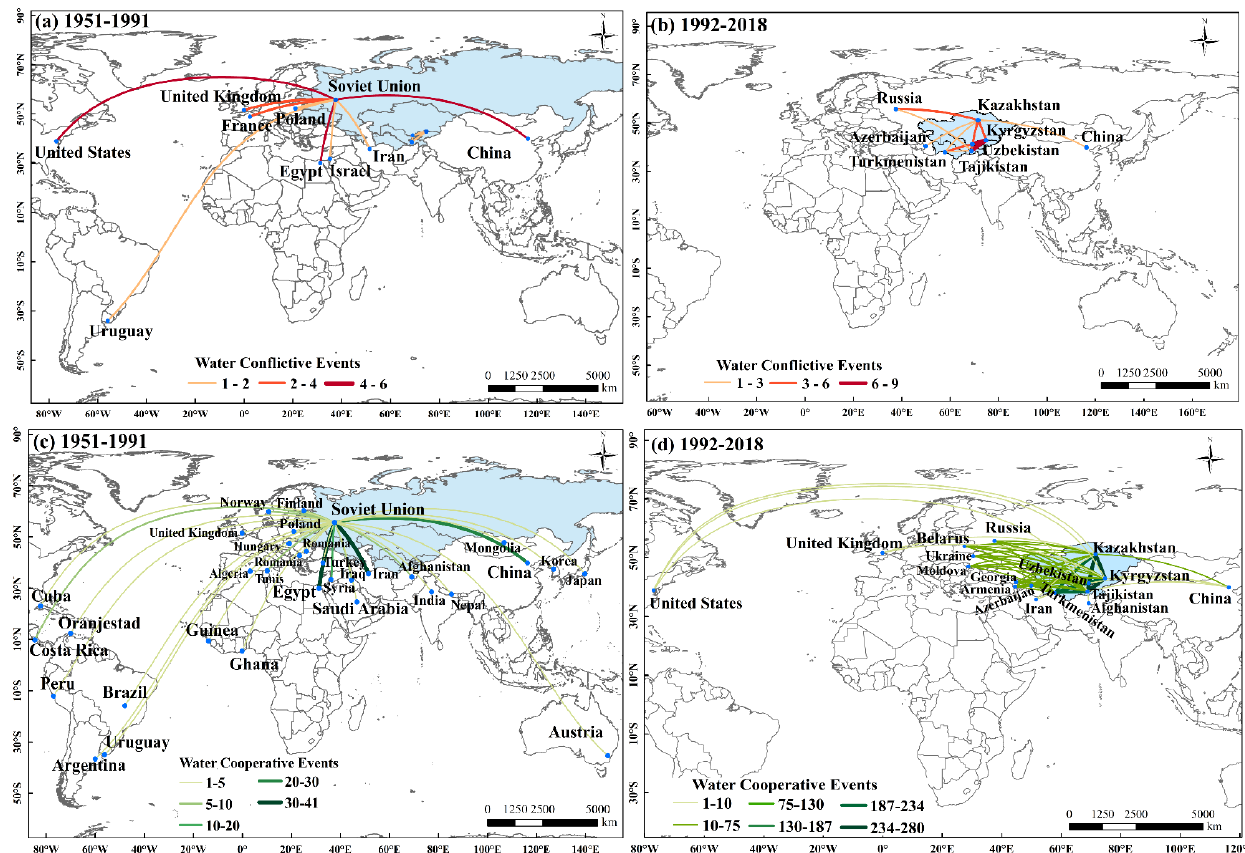
Figure 9. Water conflictive and cooperative networks between Central Asian countries and other countries in the world. (a) Number of water conflictive events in 1951–1991 and (b) 1992–2018. (c) Number of water cooperative events in 1951–1991 and (d) 1992–2018. The world and country borders are from the National Platform for Common Geospatial Information Services (https://www.tianditu.gov.cn/, last access: 4 December 2020; GS(2016)2948).